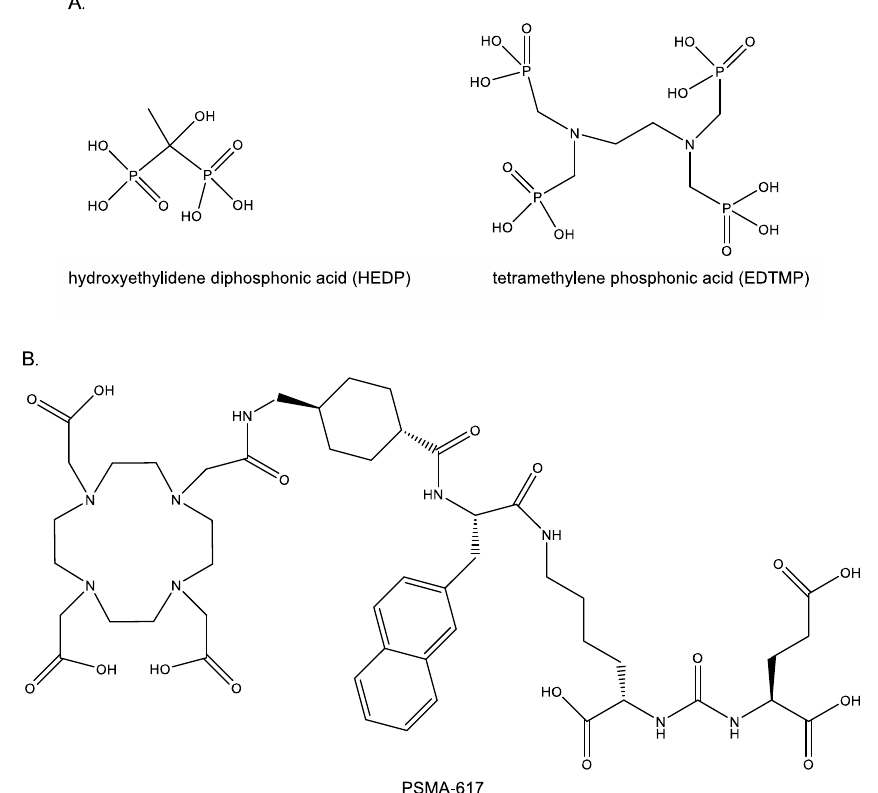
Figure 2. Several ligands used to deliver alpha-particle-emitting and beta-minus-particle-emitting radionuclides to bone metastasis. While ligands such as ( A ) hydroxyethylidene diphosphonic acid (HEDP) and tetramethylene phosphonic acid (EDTMP) target bone remodeling to deliver therapeutic radiation to bone metastases, ligands like ( B ) prostate-specific membrane antigen (PSMA)-617 target prostate cancer cell biomarkers.